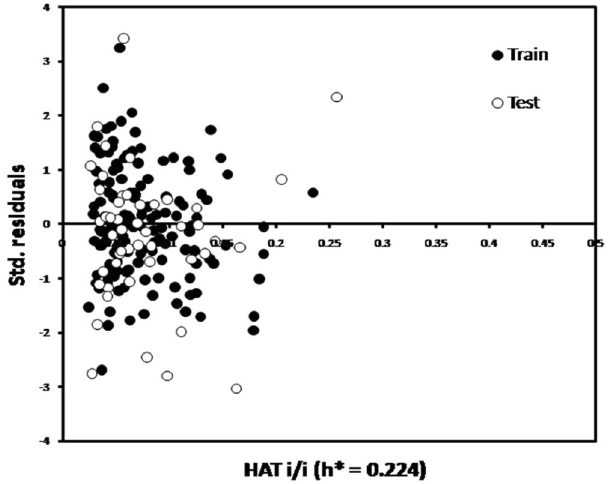
Figure3. William plot of standardized residual (SR) versus leverage (h) values for training and test sets.